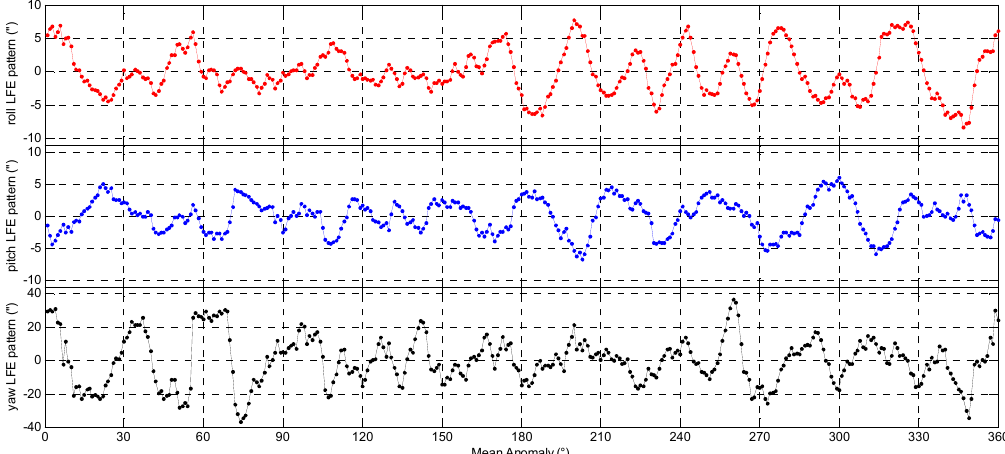
Figure 8. The low frequency errors pattern of the CCD01 star tracker.